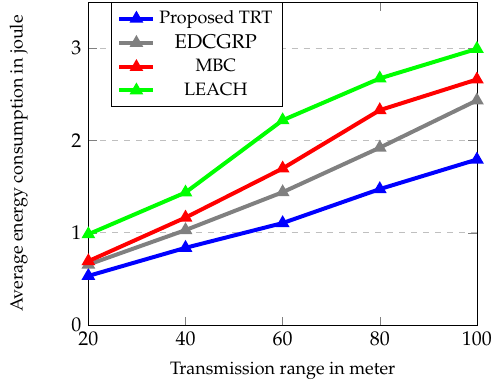
Figure 9. Average energy consumption vs. Transmission